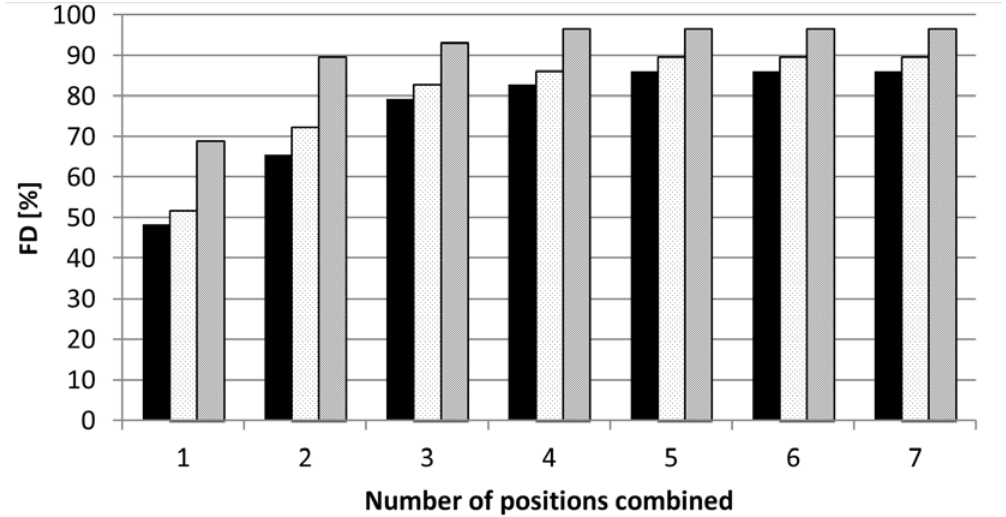
Figure 6. FD for combined positions and with different FV threshold values Results from the third session. FV threshold = 60% (black bars); 50% (white bars); 40% (grey bars).